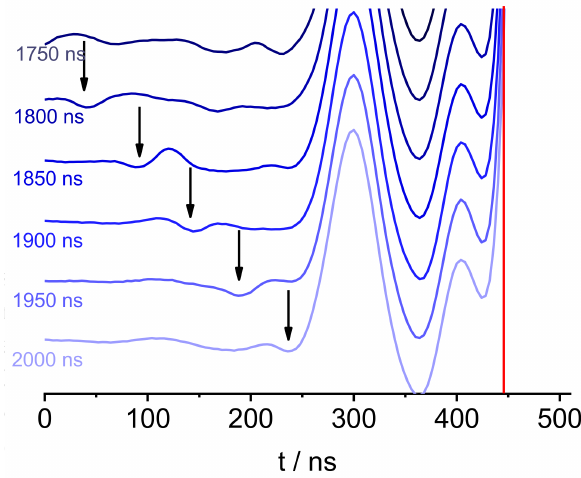
Figure 5. The transient traces of the data shown in Figure 4A (blue trace, on Ubi-DOTA-M-Gd) reveal the presence of an additional echo that traverses the observed echo (indicated by a black arrow). The number on the left refers to the time of the pump pulse (indicated as t in Figure 1). The integration interval of the observe echo starts at the red line and ends 300 nsec later (the end of the integration window is not within the scale of this